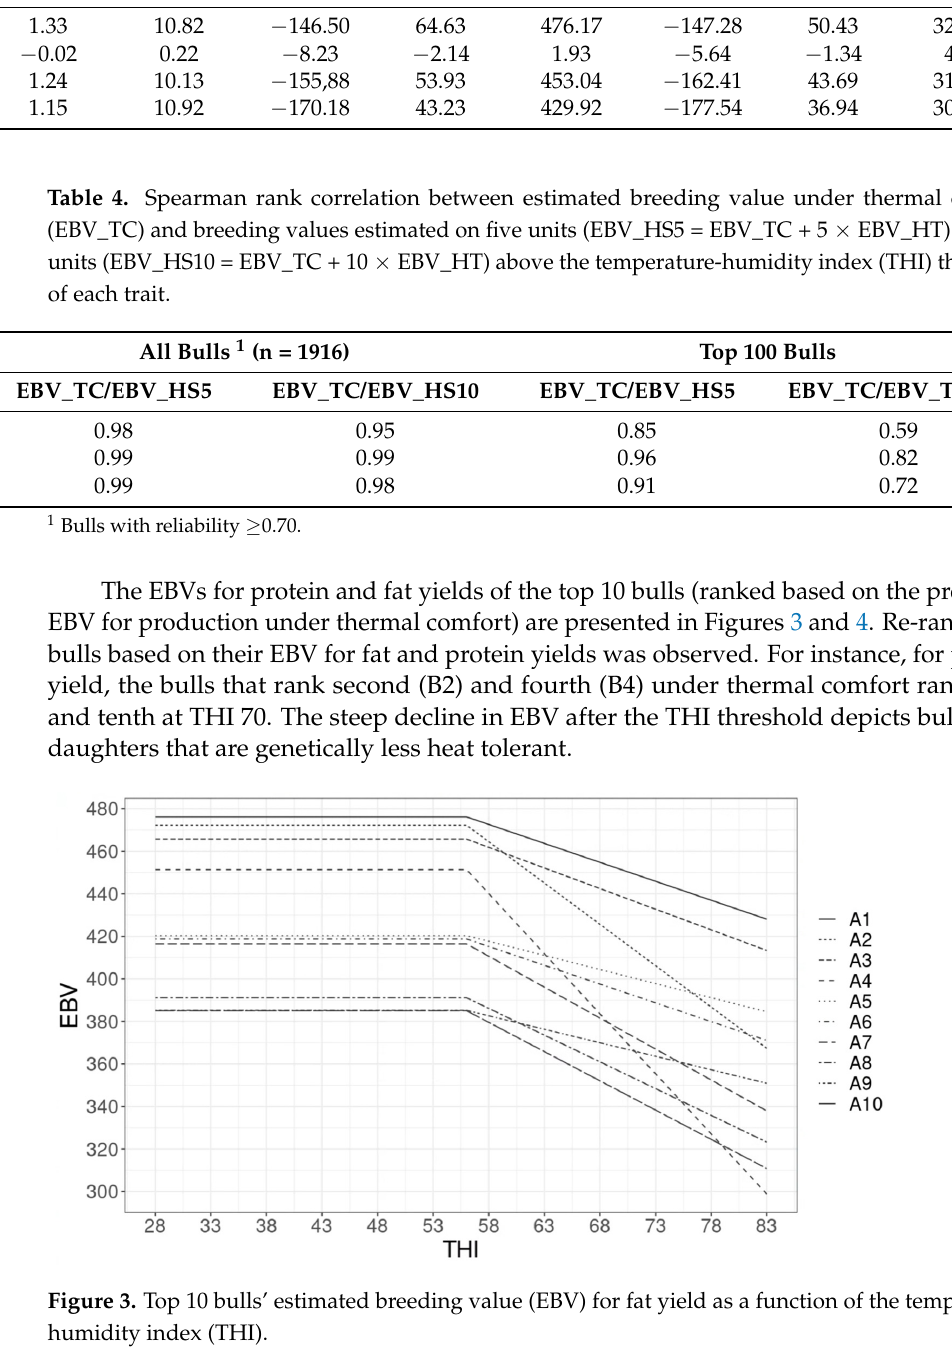
Figure 4. Top 10 bulls’ estimated breeding value (EBV) for protein yield as a function of the temperature-humidity index (THI). 4. Discussion 4.1. Milk Production and Weather Conditions The present study aimed to estimate the genetic parameters for heat tolerance for milk production traits in Canadian Holsteins cattle. Test-day records of milk, fat, and protein yields were merged with THI measurements obtained from the closest weather station to each farm. The provinces where the farms were located (Ontario and Quebec) comprise the Central Canada region and are predominantly characterized by high humidity and large seasonal variation in temperatures throughout the year. During the summer, cows are exposed to around 156 days of heat stress conditions (THI > 62) in Ontario and Quebec [20]. Many studies have highlighted the negative effects of high heat loads on production traits. In Canada, studies have shown that milk components are more affected by heat stress than milk production [19,20], which highlights the importance of addressing this environmental challenge, as Canadian producers are paid based on fat and protein yields [36].